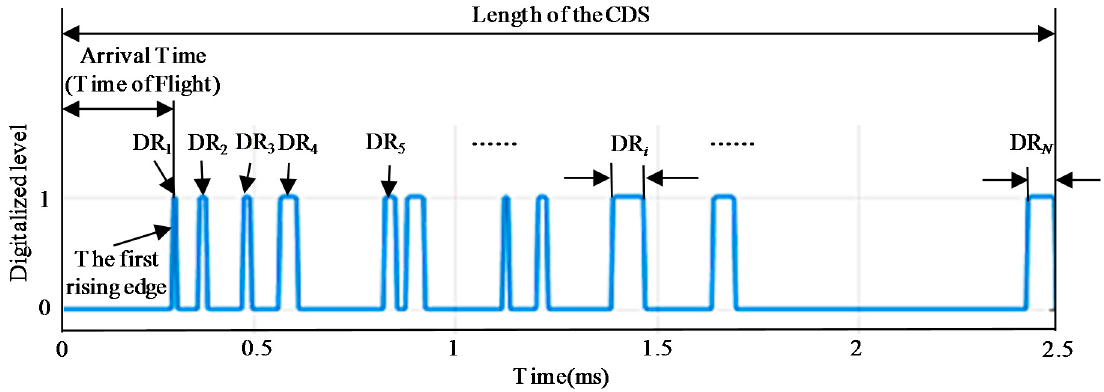
Figure 4. Illustration of the features DR and OFRE of a CDS.